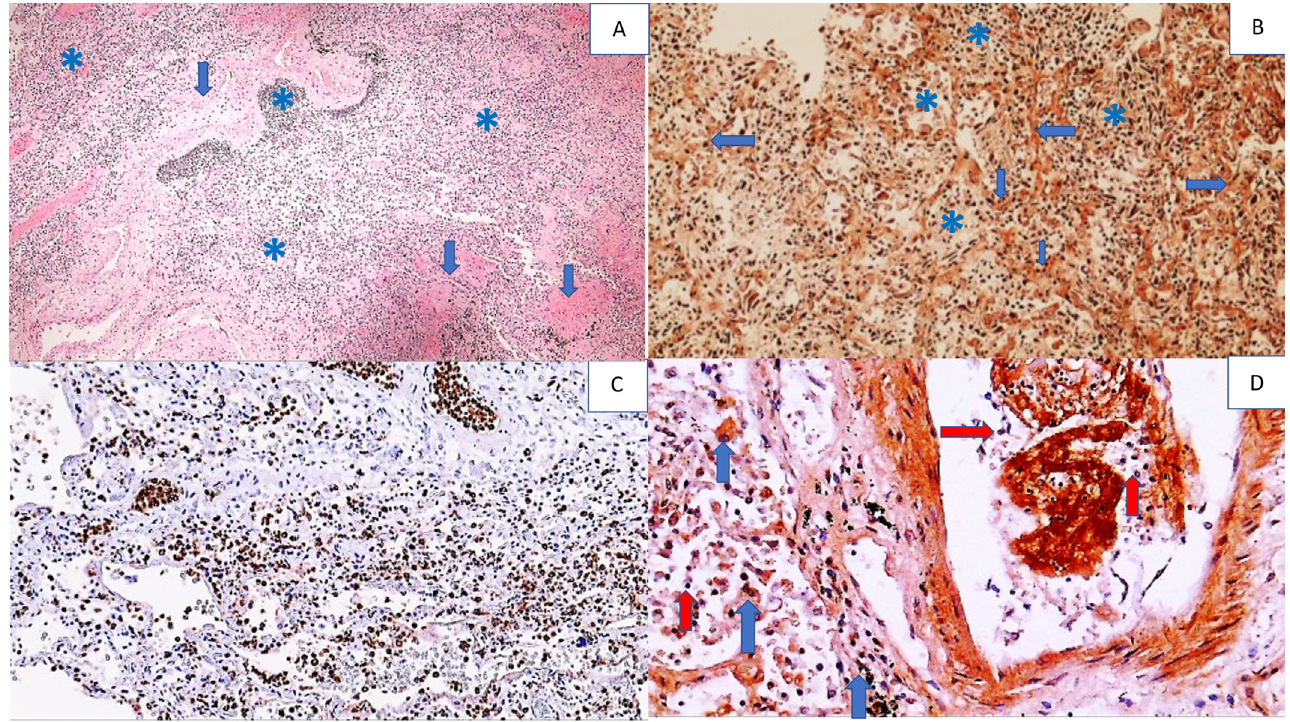
Figure 7. Histology and immunohistochemistry of the lungs of a COVID-19 patient with pneumonia and DAD. Photo ( A ) shows the destruction of pulmonary tissue with a barely recognizable structure due to severe inflammation (asterisks) and fibrosis (arrows), (HE, 50×). Photo ( B ) shows the immunohistochemical positivity for 4-HNE in the alveolar septa (arrows), edematous fluid, alveolar macrophages, and other inflammatory cells (asterisks) (DAB, 100×). In contrast, in Photo ( C ), immunohistochemical positivity for MPO is seen only for inflammatory cells stained brown (DAB, 100×). Photo ( D ) shows strong immunohistochemical 4-HNE positivity in some inflammatory cells, e.g., alveolar macrophages (blue arrows), while other inflammatory cells, such as mononuclear cells, in the vessel and lung tissue are negative 4-HNE-negative (red arrows) (DAB, 400×).